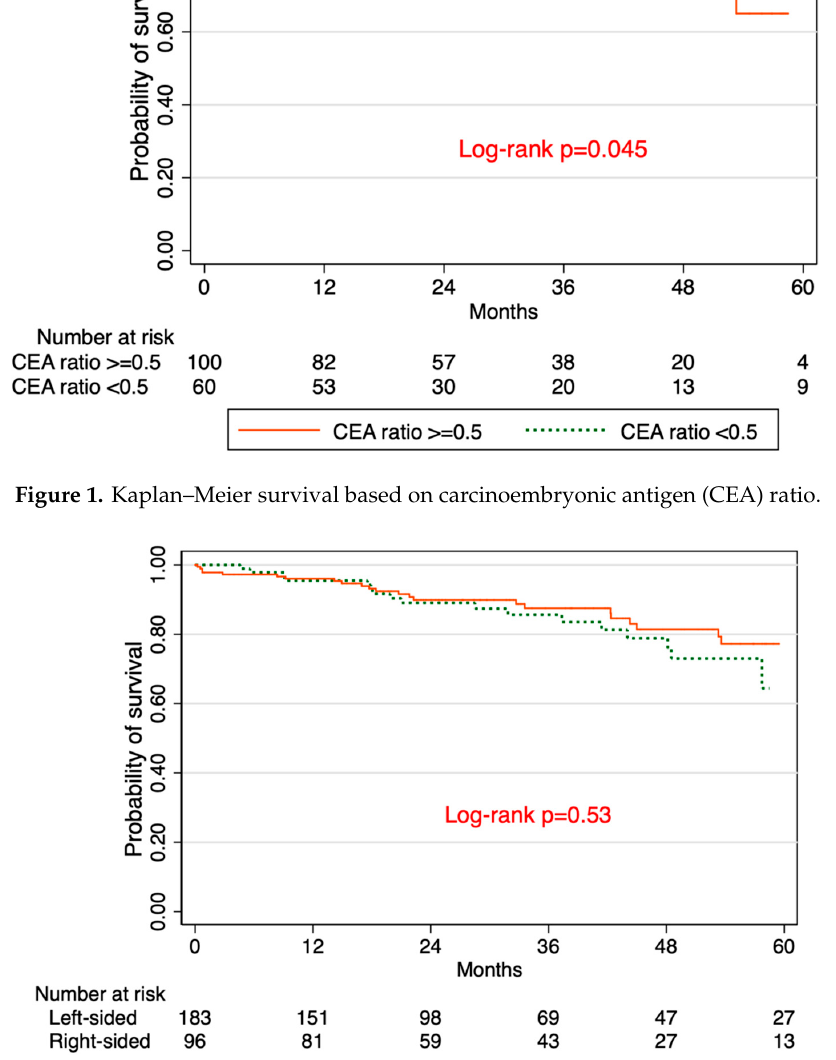
Figure 3. Kaplan–Meier survival based on tumor location among those with CEA >5 at the time of recurrence. Table 1. Tumor location in patients categorized by age, sex, smoking status, CEA ratio, and tumor stage.